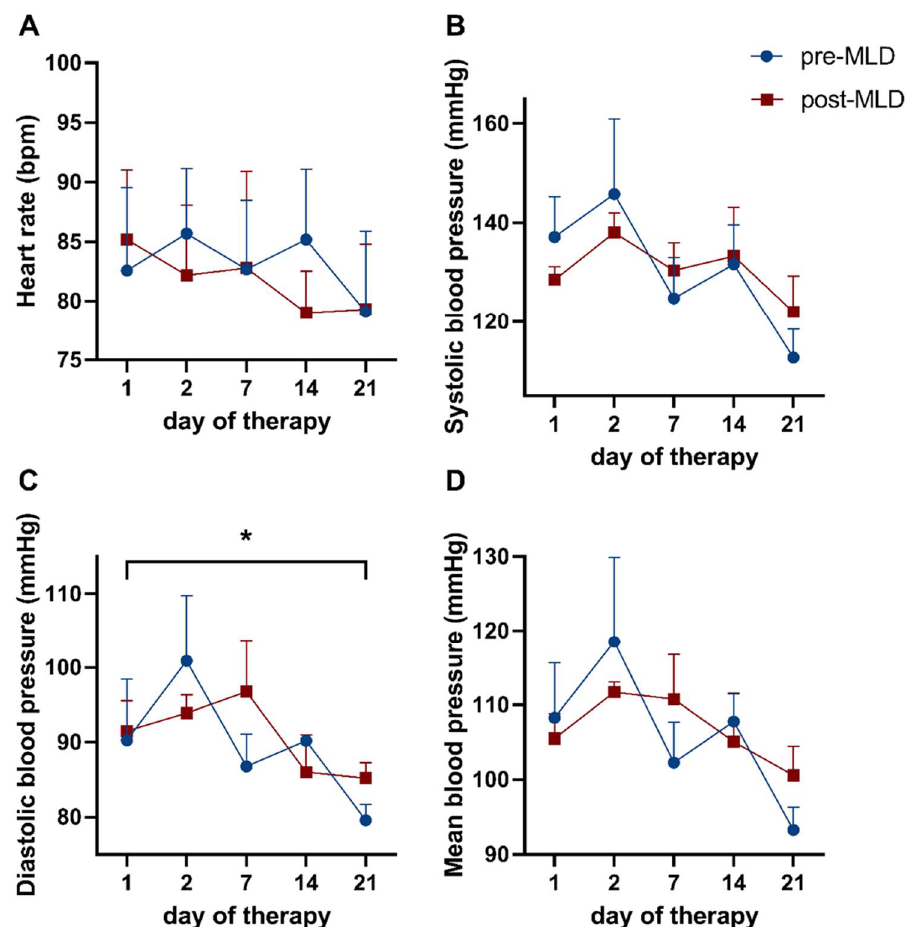
Figure 3. Time course showing baseline hemodynamic parameters over three weeks of complete decongestive therapy (CDT), before and after manual lymphatic drainage (MLD). Displayed are ( A ) heart rate, as well as ( B ) systolic, ( C ) diastolic, and ( D ) mean blood pressure. Data before MLD are depicted as blue dots; values after MLD are shown as red circles. Asterisks mark significant differences (*). Note: ticks on the x -axis (day of therapy) are not spaced equally in time. Table 2. Changes in resting hemodynamic parameters (baseline values) during three weeks of complete decongestive therapy, pre- vs. post-manual lymphatic drainage (MLD). The data are displayed as means ± standard deviation.